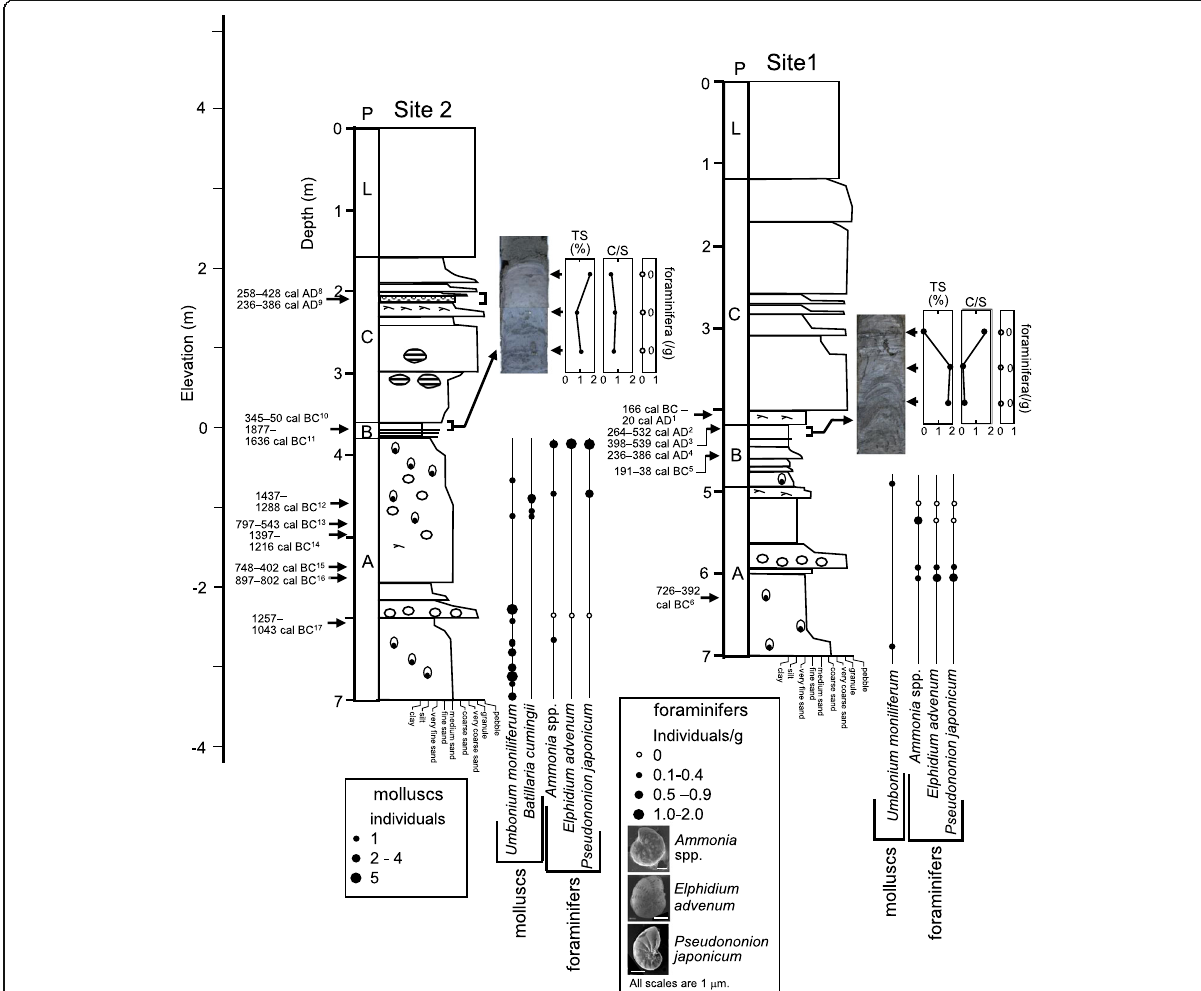
Fig. 8 Stratigraphic distributions of the dominant species of mollusk fossils, total sulfur content (TS), ratio of total organic carbon to TS (i.e., the C/ S ratio), and foraminifera in cored deposits at sites 1 and 2. See Fig. 5 for